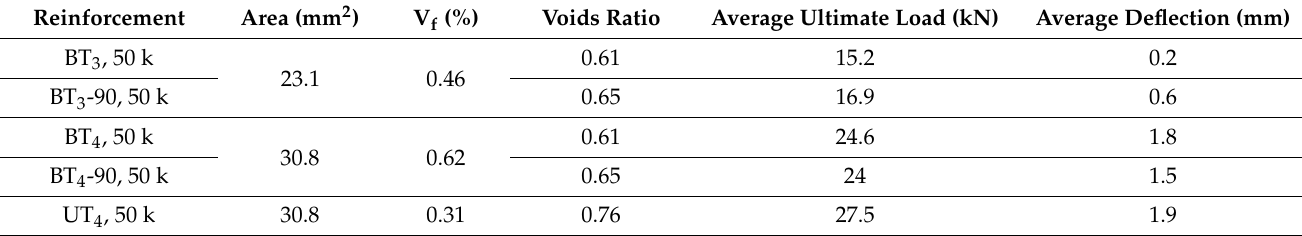
Table 3. Voids ratio and average ultimate load and deflection of bi-axial textile TRC beams.